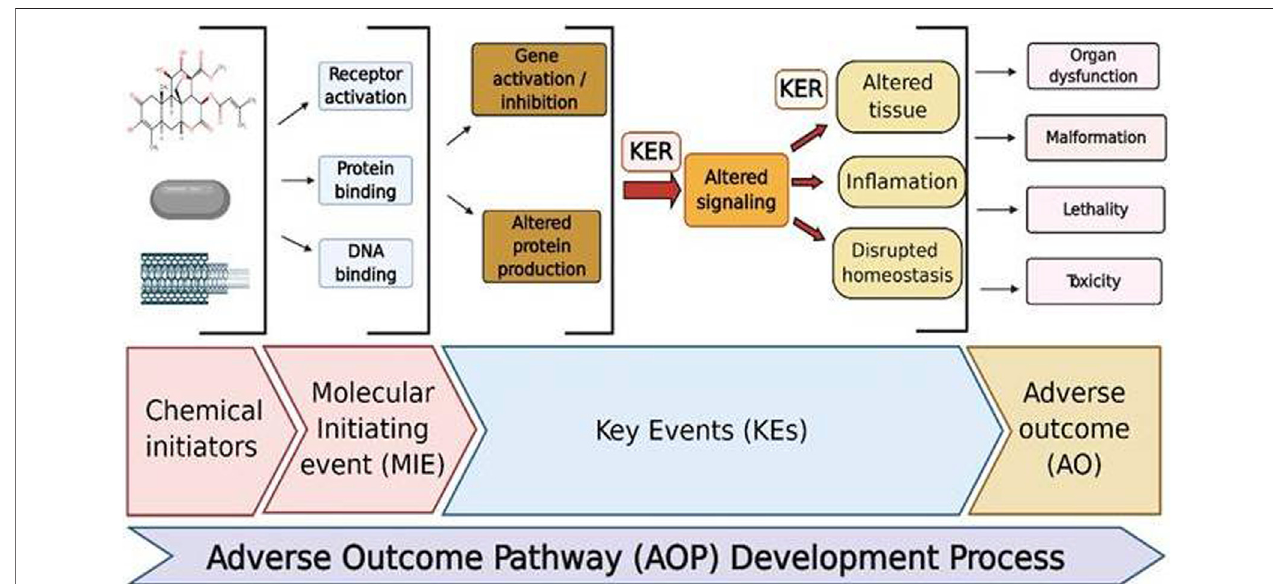
FIGURE 6 | Process of development of AOP includes chemical initiators (chemical or NPs or nanotubes) which will bind to receptor, protein, or DNA causing cascadeimpactonthesignalingpathway.Theinitialinteractionwithbiologicalsystemisthemolecularinitiatingevent(MIE),whichfurtherleadstothedevelopmentofkey events (KEs) and fi nally causes apical adverse outcome (AO). The relationship between the two key events is designated as key event relationships (KER).